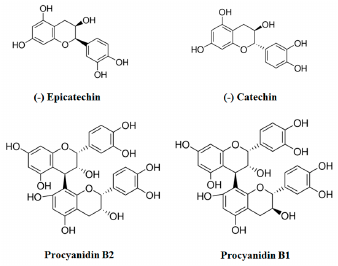
Figure 1. Main flavonoids present in fermented cocoa. Chemical structures of ( − )-epicatechin and ( − )-catechin and their respective dimmers, procyanidins B2 and B1.